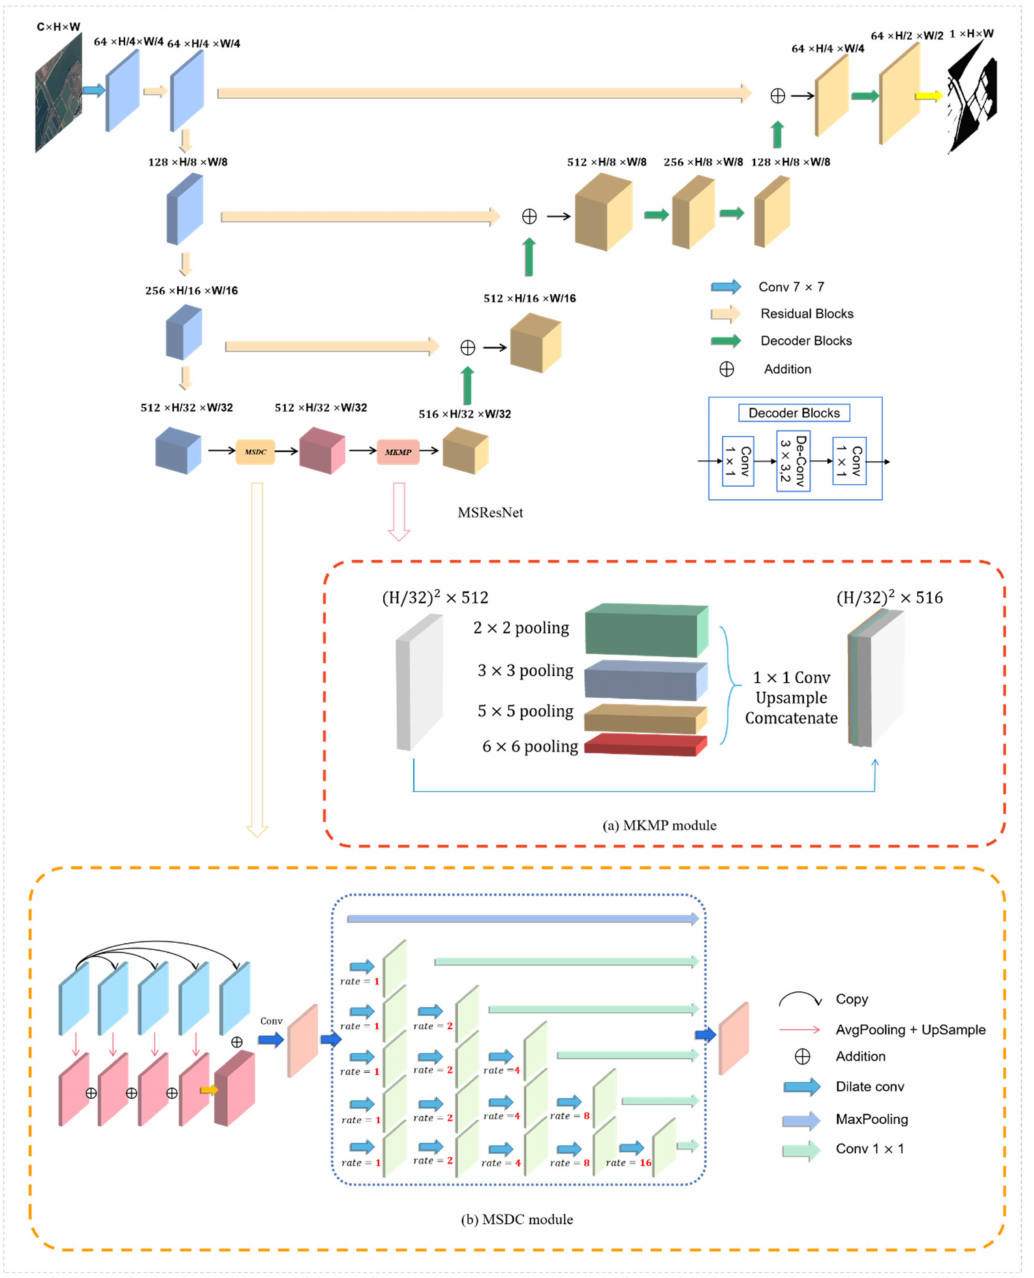
Figure 1. The structure of the proposed MSResNet including the ( b ) MSDC module and ( a ) MKMP